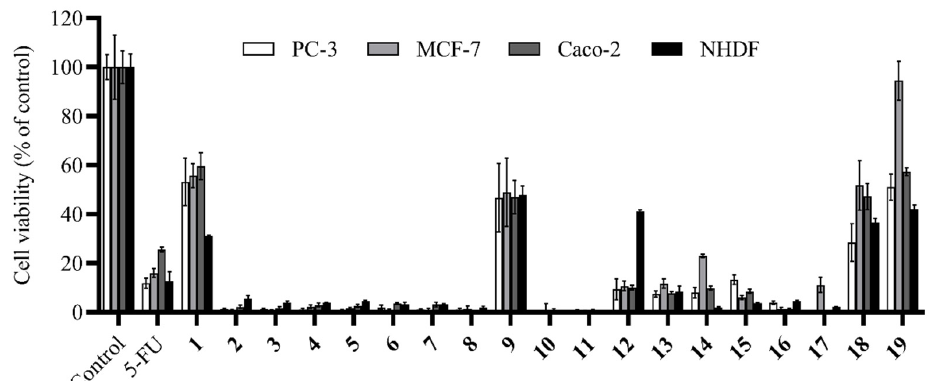
Figure 1. In vitro effects of bisbenzothiazole 1 , the dyes 2 – 19 , and 5-fluorouracil (5-FU) on the cell viability of human prostate (PC-3), breast (MCF-7), and colorectal (Caco-2) adenocarcinoma cell lines and a non-tumourous cell line of normal human dermal fibroblasts (NHDF). A single concentration of 10 µ M was used for 72 h. Results are expressed as mean ± standard deviation of two independent assays performed in quadruplicate. Differences from the control were significant ( p < 0.001, Student’s t -test) for all compounds except the dye 19 in the MCF-7 cell line (absence of any statistical difference).